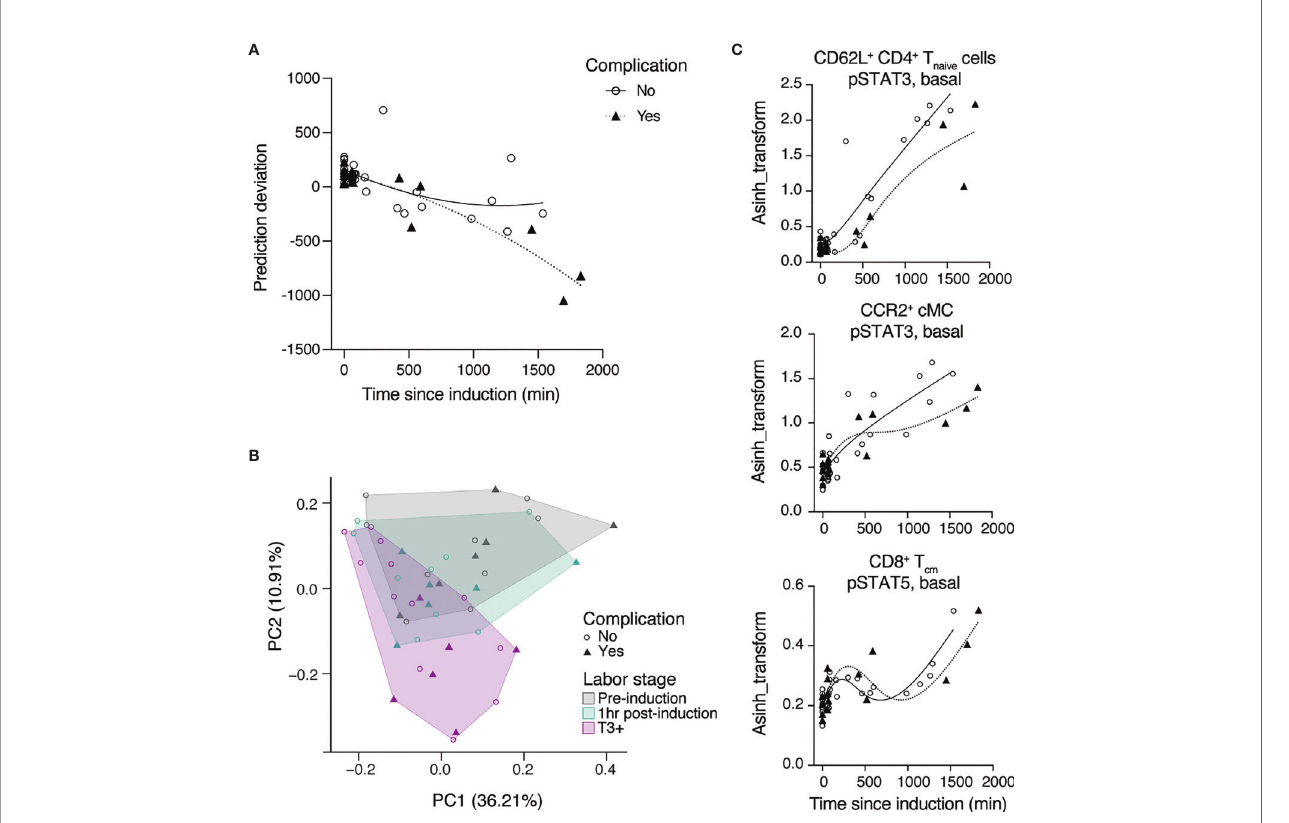
FIGURE 4 | Differences in immune trajectories between complicated and uncomplicated labor. (A) Prediction deviation from the true TSI [residual error (predicted – true TSI)] strati fi ed by absence (open circles) or presence (triangles) of labor complications. (B) PCA analysis identi fi ed two components that explain 36.2% (PC1) and 10.9% (PC2) of the variation across phases of latent labor, where complicated labor (triangles) majorly clusters along the axis of PC2. (C) Representative features among the top predictive features which follow different trajectories in patients with (triangles) or without (open circles) complications after the induction of labor (lines represent splines with 4 knots). See also Supplementary Table 3